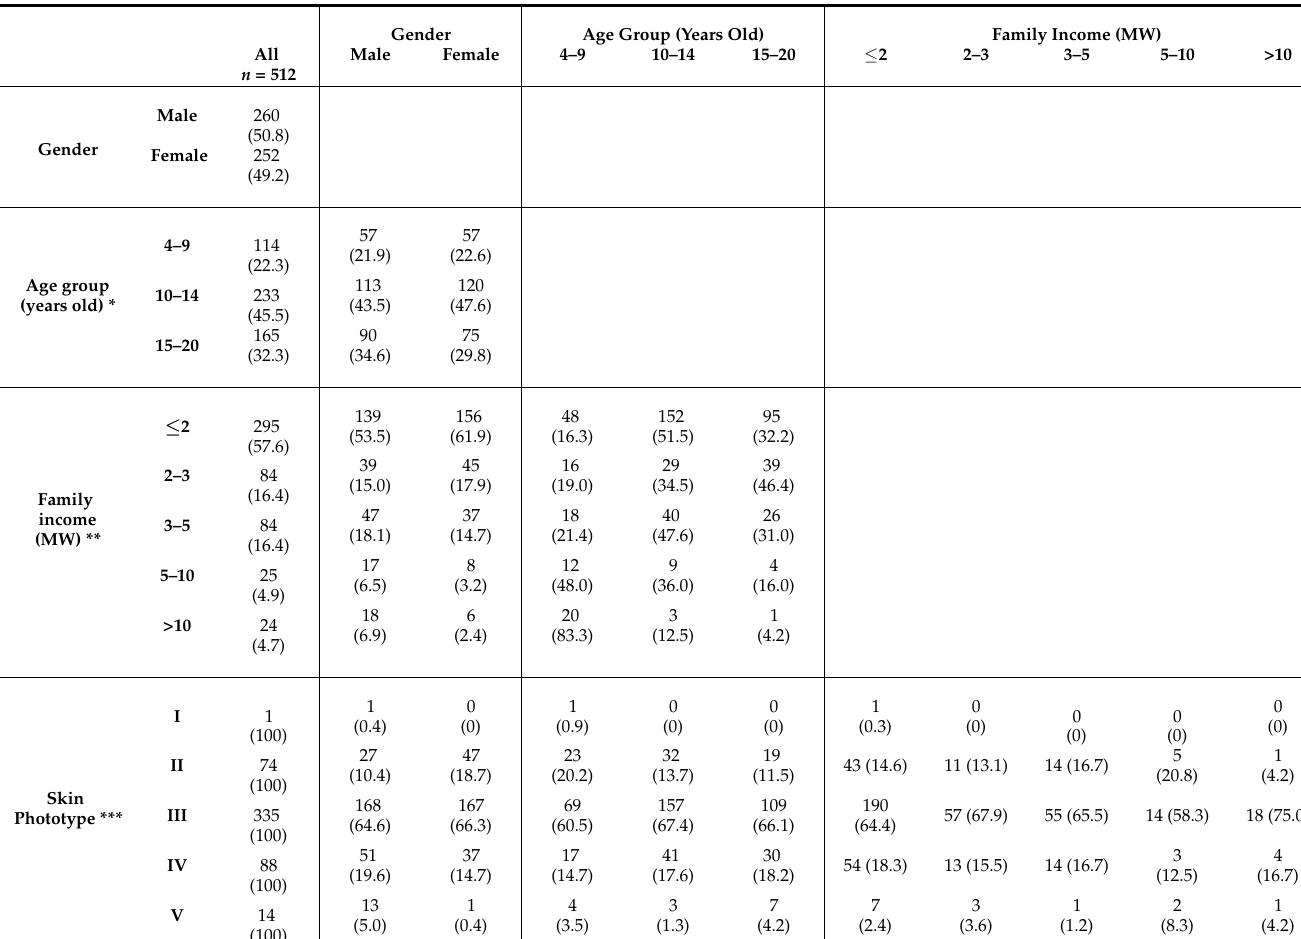
Table 3. Characteristics of the population (subanalysis for gender, age group, family income, and skin phototype). Upper numbers indicate absolute responses and numbers in the parentheses indicate relative frequencies